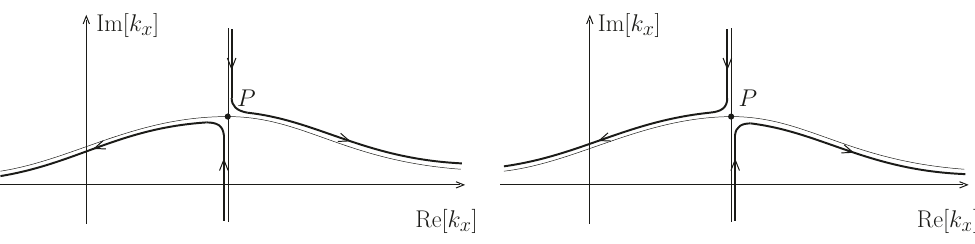
Figure 6 . Solutions (3.1) of the pinching condition (2.4) as functions of p 0 in D = 2, for Im[ p 0 ] & 0 and Im[ p 0 ] . 0, respectively. The vertical line is Re[ k x ] = p x = 2.